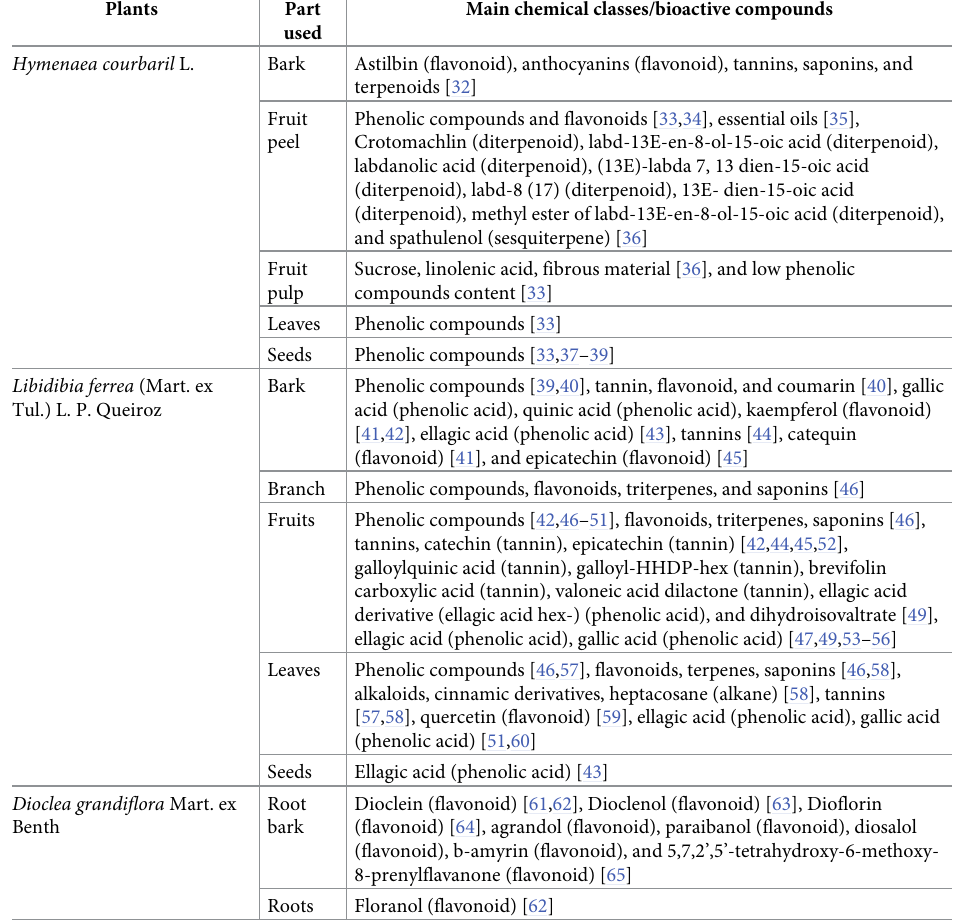
Table 2. Chemical profile of food tree legumes occurring in Caatinga. Plants Part Main chemical classes/bioactive compounds used Hymenaea courbaril